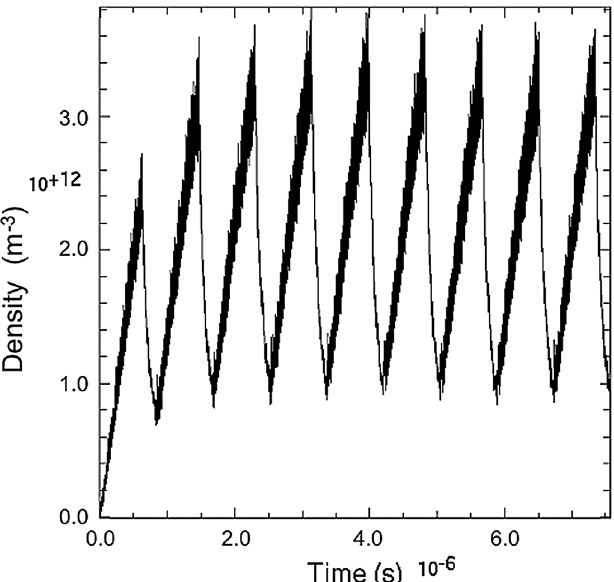
FIG. 14. Density averaged over a cylinder of radius 1 mm concentric with the chamber axis with a length extending through the entire wiggler period. Nine trains of 45 bunches separated by 15-bunch gaps.